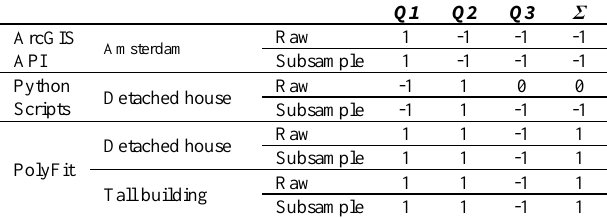
Table 8. Points awarded in every question to every software on in each scenario. Scores given as ‘1’ for ‘ Yes ’, ‘-1’ for ‘ No ’ and ‘0’ for ‘ Not completely ’.